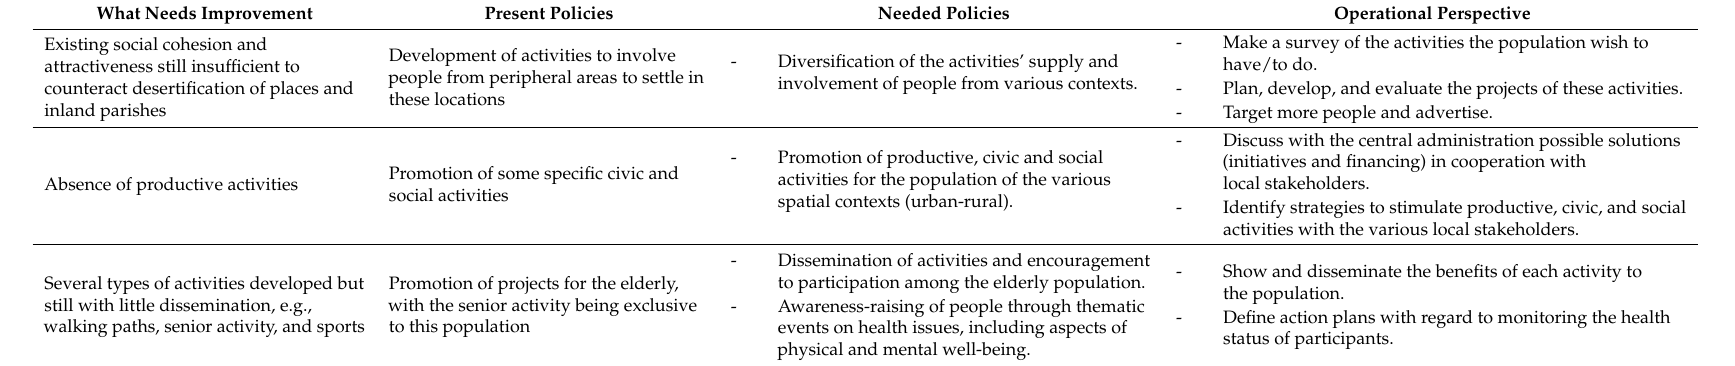
Table 3. Viseu and activities for the elderly: from what is being done to what is needed (Aveiro, Portugal